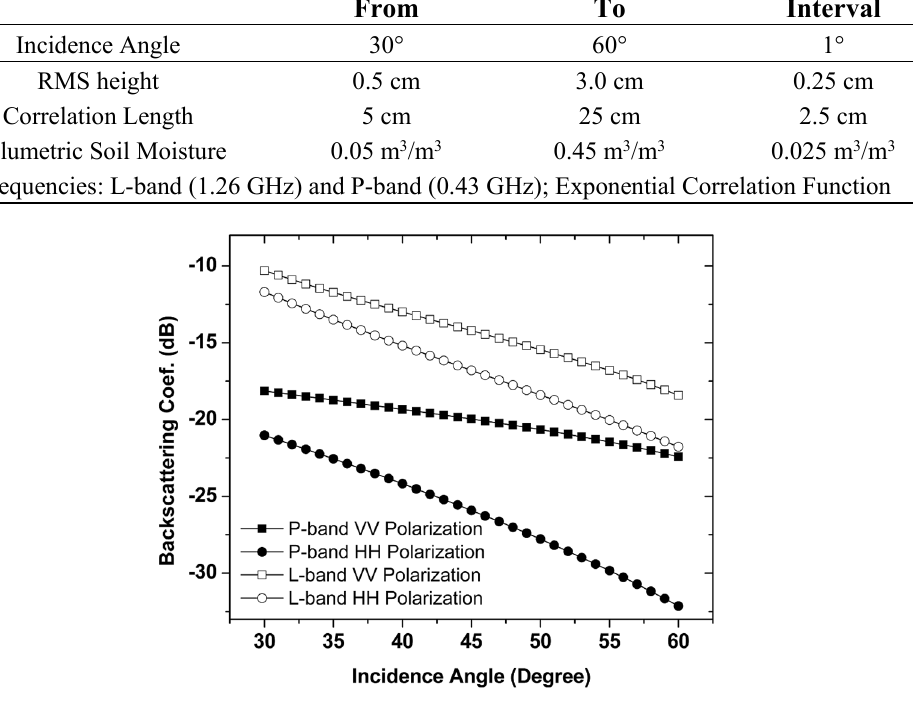
Figure 7. Radar backscatter angular responses for L- and P-band frequencies based on AIEM simulations with the following input parameters: RMS height 1.25 cm, correlation length 10 cm, volumetric soil moisture 0.25 cm 3 /cm 3 and exponential correlation function.